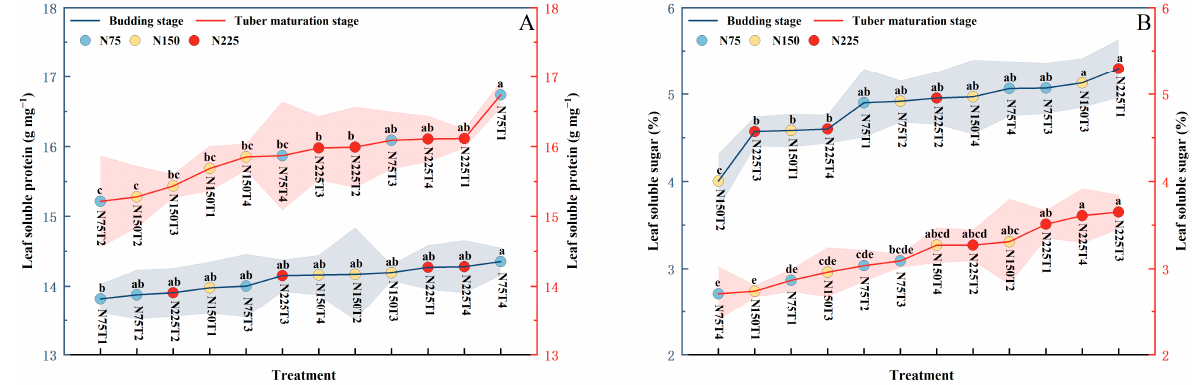
Figure 3. Leaf soluble protein ( A ) and leaf soluble sugar ( B ) content, broken lines show means of the budding stage (blue) and tuber maturation stage (red), shade along the broken line indicate standard errors ( n = 3), di ff erent lowercase le tt ers indicate signi fi cant di ff erences between treatments ( p < 0.05). Balls of N75 in blue, N150 in yellow, and N225 in red are sorted by size.